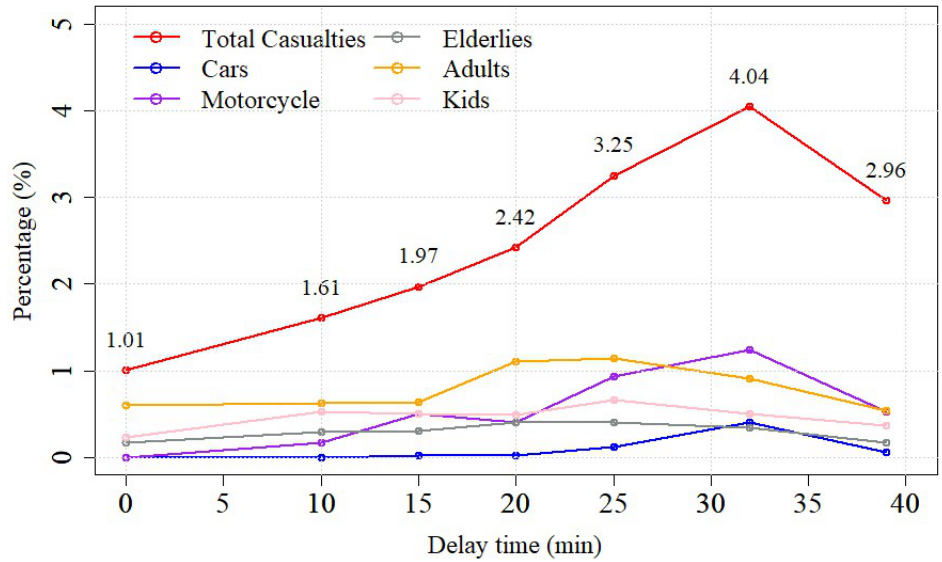
Figure 9. Resulting casualties (%) depending on the delay time, τ